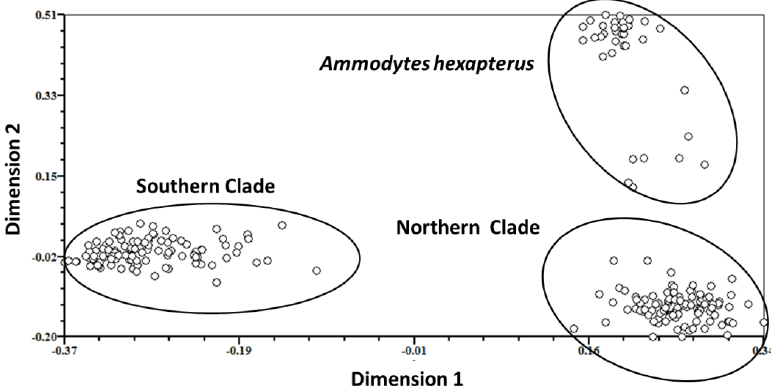
Figure 4. NJ tree based on Nei’s (1972) original genetic distances among populations [26]. The mtDNA lineages for each population were calculated from Han et al. [15]. Bootstrap supports of > 90% in 1000 replicates are shown.